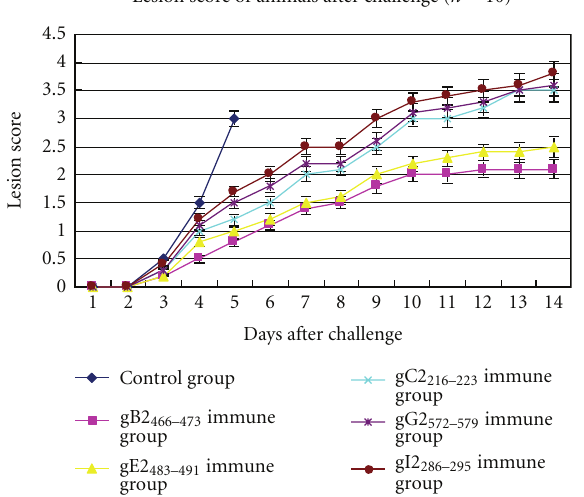
Figure 3: Lesion score of the immunized animals after HSV-2 challenge.